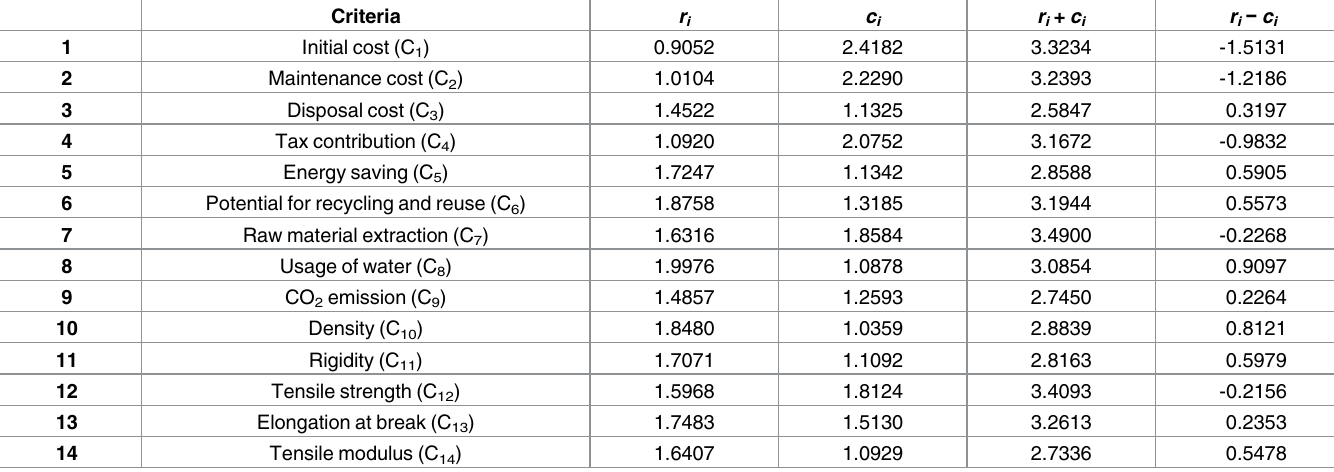
Table 5. Sum of the influences given and receivedregarding criteria.